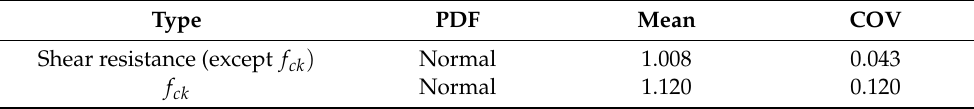
Table 20. Probabilistic models for Monte-Carlo simulation with the 4-rib case.